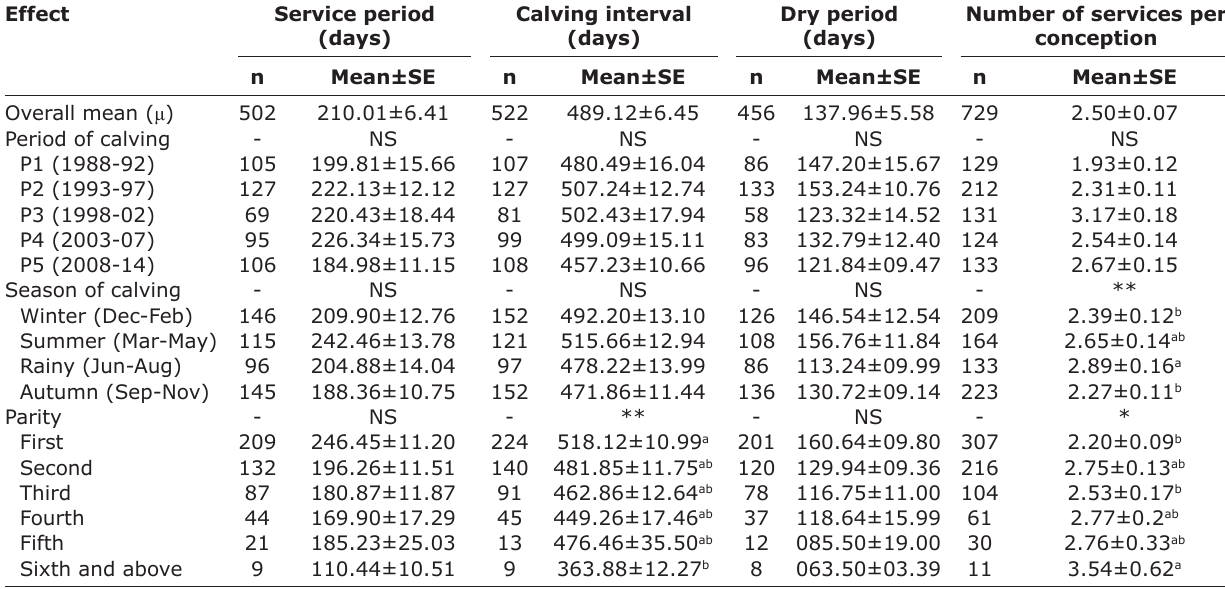
Table-1: Least-squares means (±SE) for service period (days), calving interval (days), dry period (days), and number of services per conception in Jersey×Red Sindhi crossbred cows.